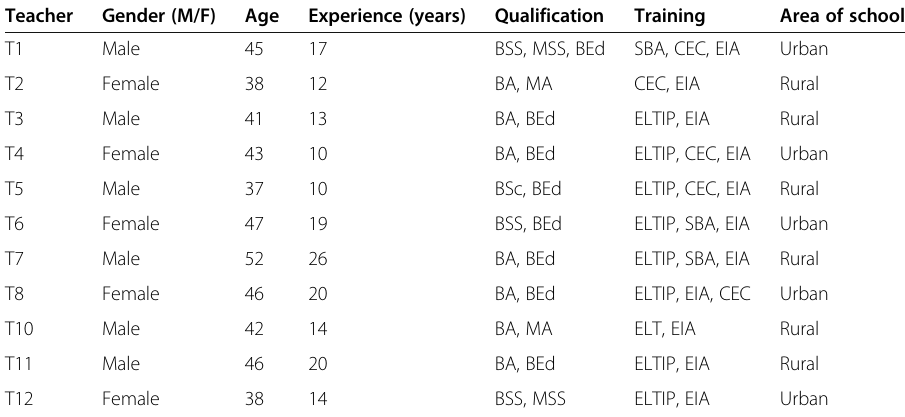
Table 1 Profile of the sampled English